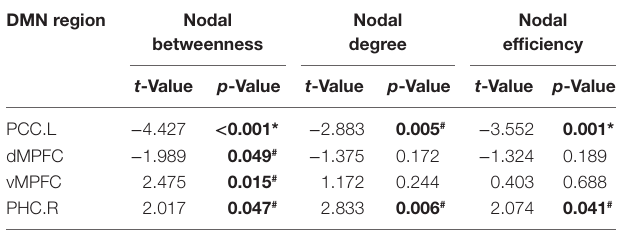
Patients with OSA showed abnormal nodal centrality in PCC.L, dMPFC, vMPFC, and PHC.R, which showed significant between-group differences in at least one of the three nodal metrics. # p < 0.05,